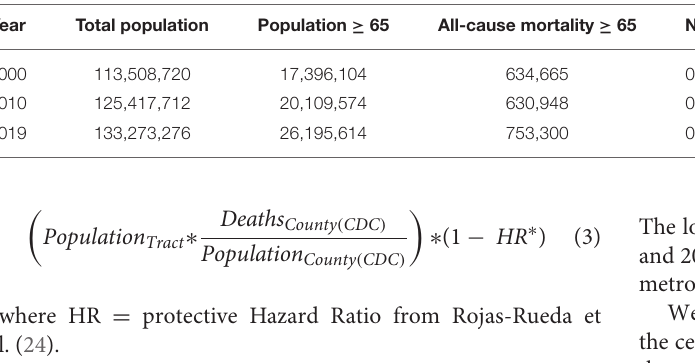
TABLE 1 | Summary statistics of population, exposure, and estimated reduction in all-cause mortality in study